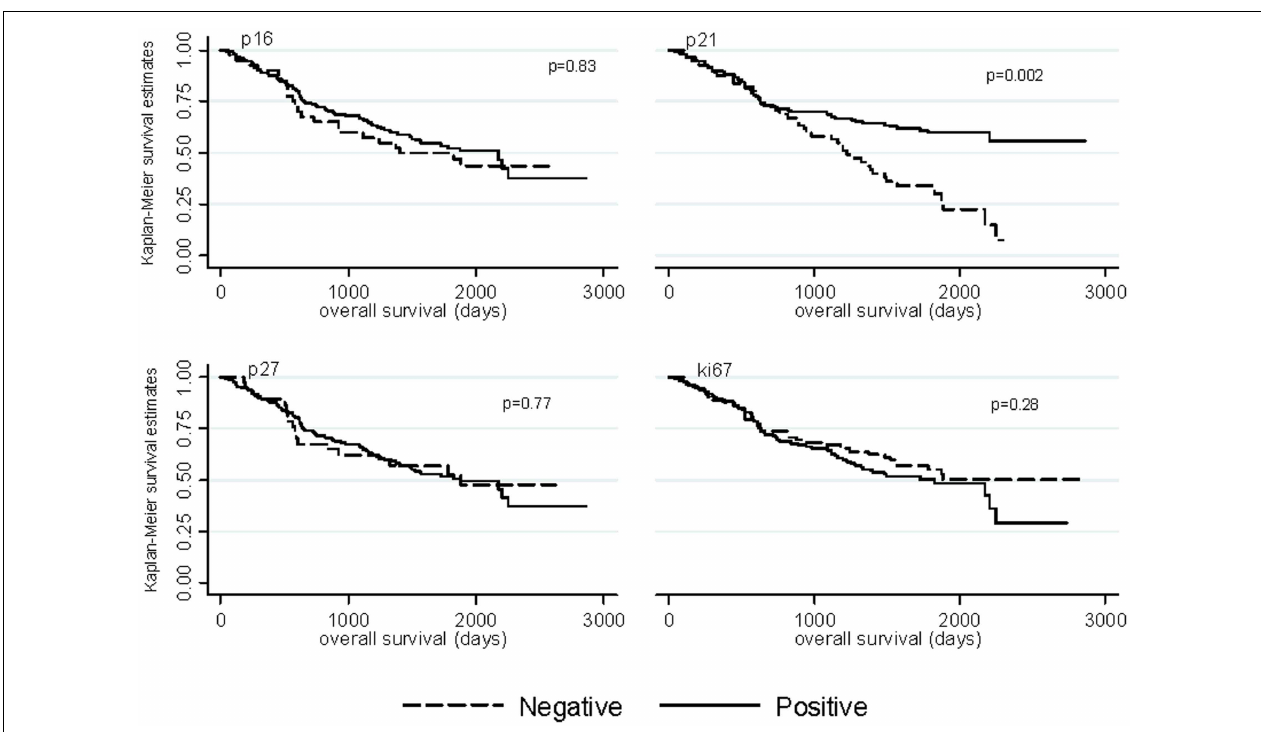
FIGURE 1 | Kaplan–Meier overall survival curves by p16, p21, p27, and ki67 expression among ovarian cancer patients .